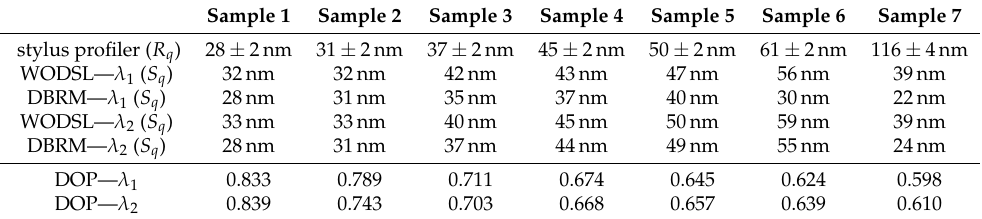
Table 2. Simulation results for seven (reflecting) samples according to Chandley’s method without considering the depolarization of the scattered light (WODSL) [22] and according to the model describing the DBRM technique with λ 1 = 488.0nm and λ 2 = 632.8nm. Moreover, the uncertainties of the measurements (see Table 1) and the simulated degrees of polarization (DOPs) for λ 1 and λ 2 are